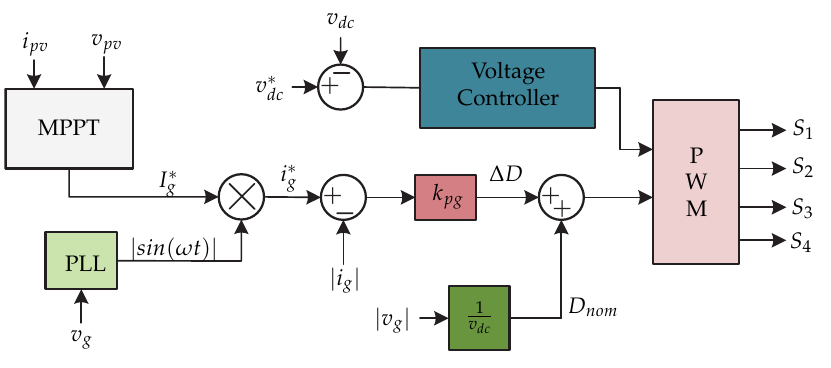
Figure 15. Control strategy proposed in [25].